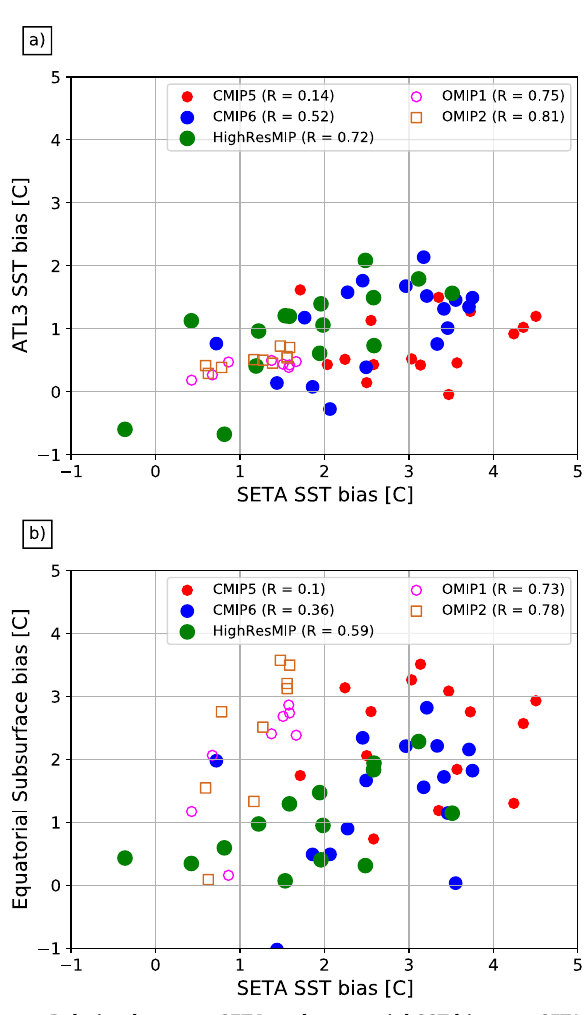
Fig. 7 Relation between SETA and equatorial SST biases. a SETA vs ATL3 SST biases in CMIP models. The ATL3 region is de fi ned between 5 ∘ S – 5 ∘ S and 10 ∘ W – 0 ∘ E. b Same as in ( a ) but for SETA SST and the equatorial subsurface temperature biases (averaged between 2 ∘ S – 2 ∘ N, 10 ∘ W – 10 ∘ E, and 50 – 150